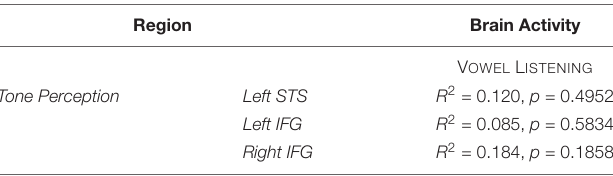
TABLE 5 | CCA results in tone perception regions, between vowel listening brain data and the articulatory model at group level.